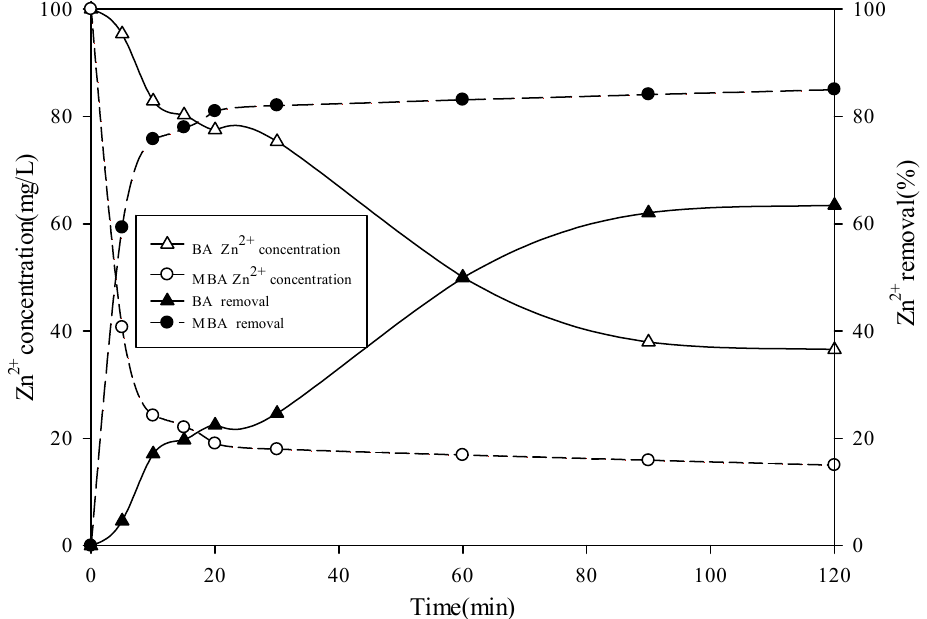
Figure 2. Sorption kinetics of the materials (initial concentrations of Zn 2+ , 100 mg/L; biomass ash and modified product concentration, 2 g/L; T = 30 °C; initial pH 5.0; BA = biomass ash, MBA = modified biomass ash). Table 4. Kinetic parameters for biomass ash and the synthesized matrix.